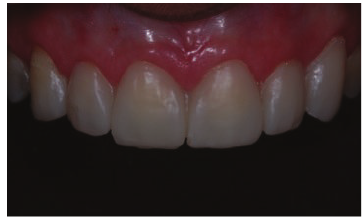
Figure 9: Removal of bone tissue with manual instrument.